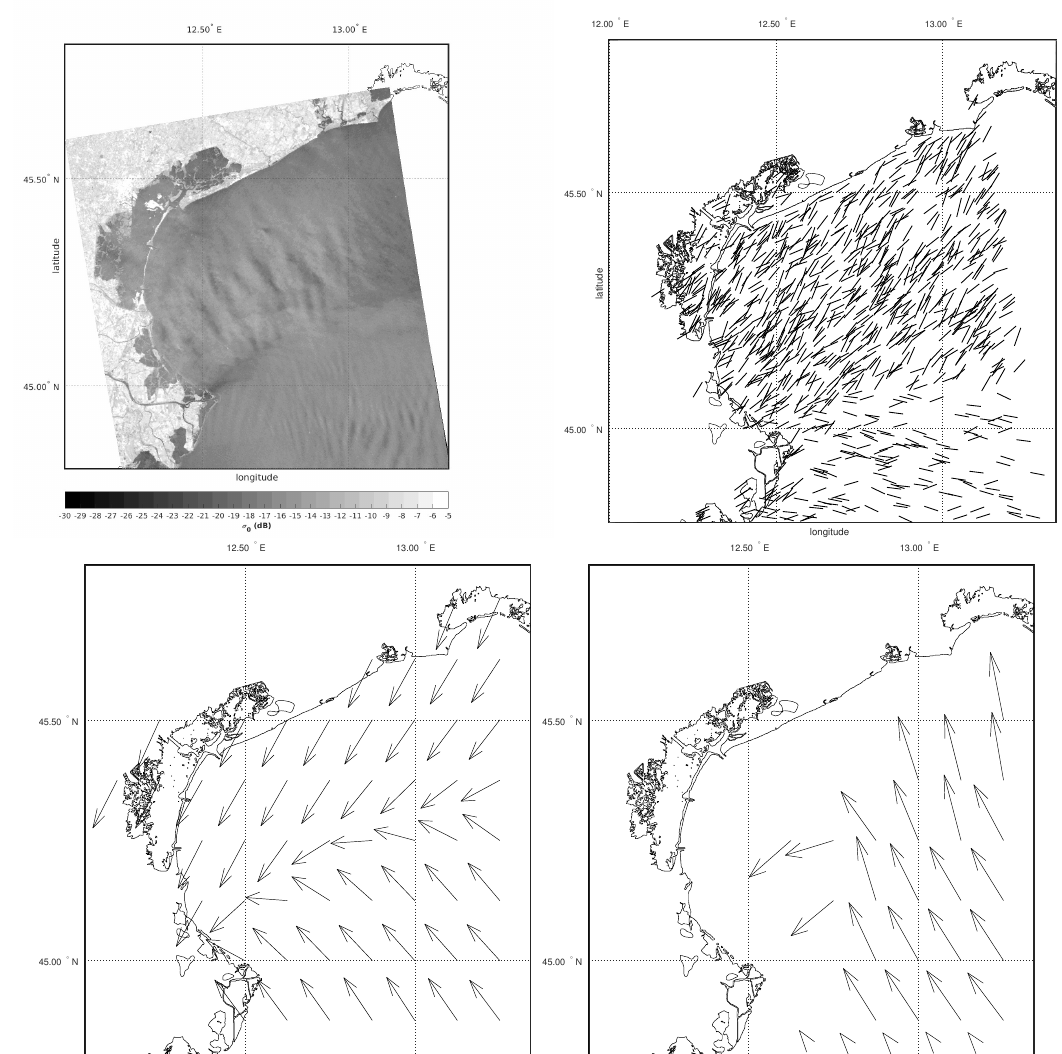
Figure 7. A case of discrepancy between the SAR, ECMWF and scatterometer wind directions in the northern Adriatic Sea, 5 February 2017 at 5:05 p.m. GMT. Top left panel : the Sentinel-1B SAR image S1B_IW_GRDH_1SDV_20170205T170532_20170205T170600_004168_007363_EC8E. Top right panel : SAR aliased wind direction field obtained by the 2D-CWT. Bottom left panel : ECMWF wind field interpolated on the SAR pass time. Bottom right panel : wind field at 7.09 p.m. GMT from the EUMETSAT Advanced